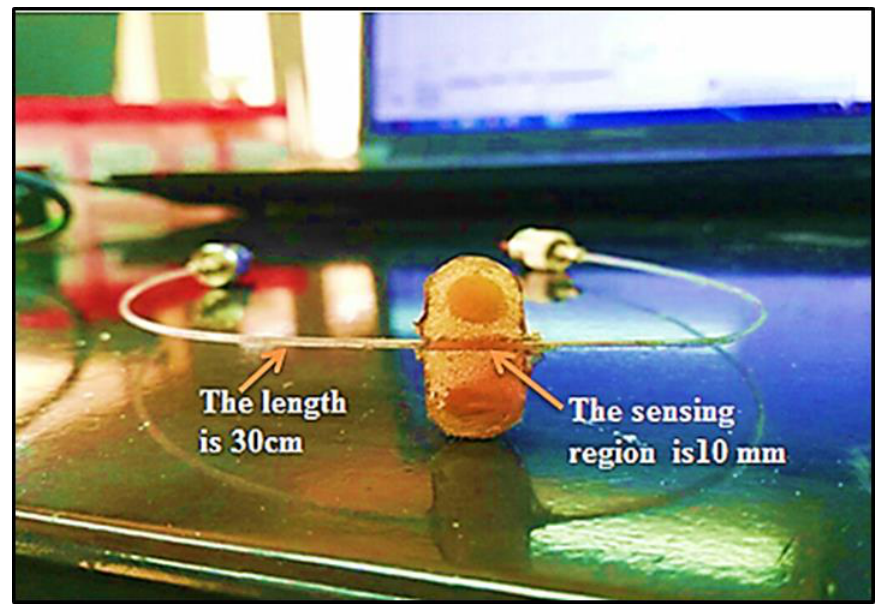
Fig.3: The photograph of the optical grade plastic optical fiber sensor.